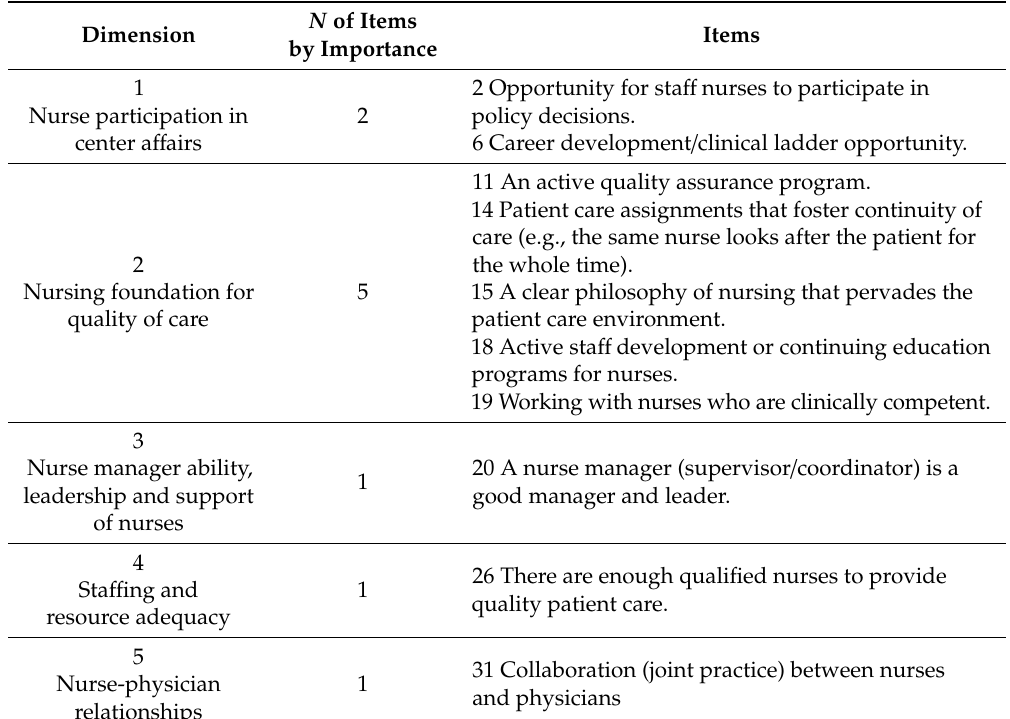
Table 4. 10 main elements in the PES-NWI 1 questionnaire as selected by